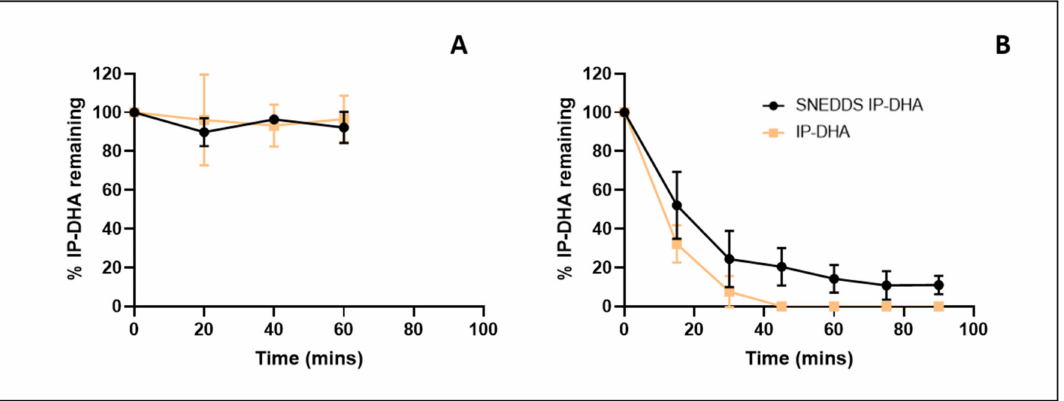
Figure 6. Stability of IP-DHA in SGF ( A ) or ISF ( B ) after dilution of free IP-DHA or SNEDDS-IP-DHA at 30 mg/mL ( n =